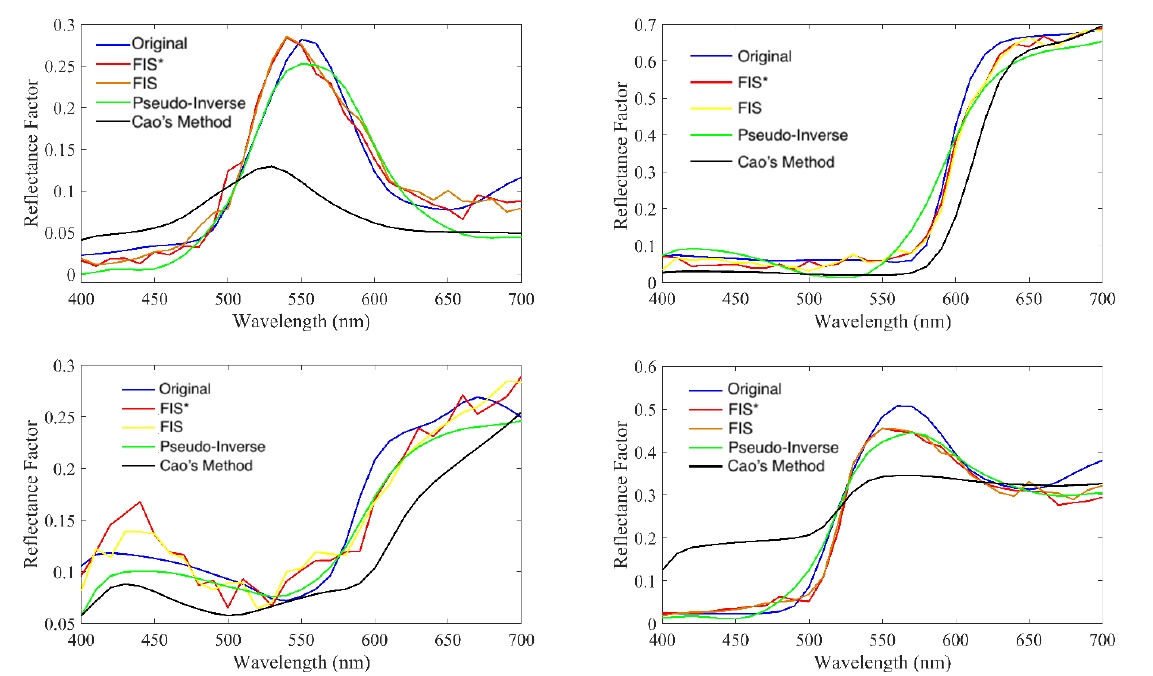
Figure 15. Four randomly selected samples along with their recovered ones using the RGB methods in the